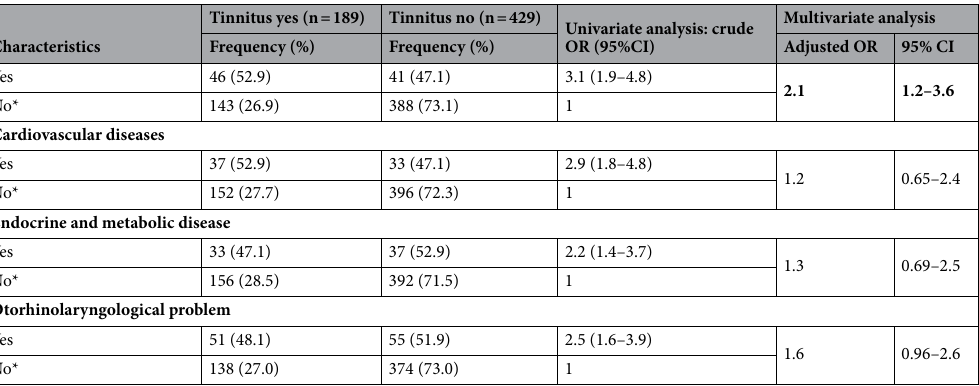
Table 5. Analysis of potentially associated factors with tinnitus. AOR adjusted odds ratio, CI confidence interval . Significant values are in bold. *Reference